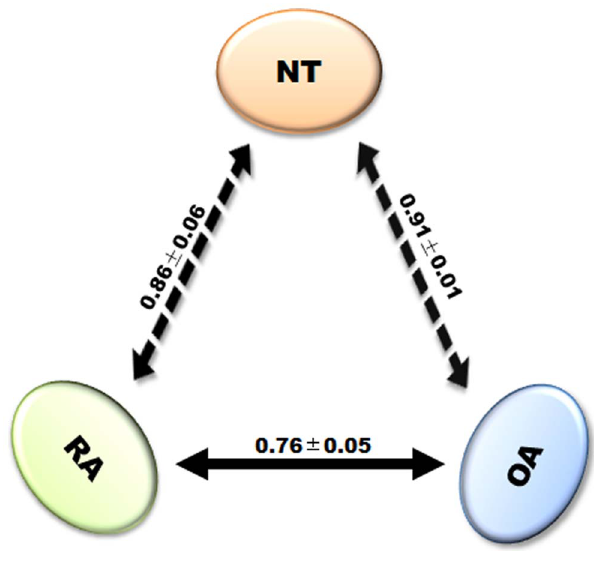
Figure 2. Average expression distances between RA, OA and NT samples. The average distances and the standard errors were labeled in the figure. The distance between pathological samples (RA or OA) and NTs is significantly larger than the distance between RA and OA samples.